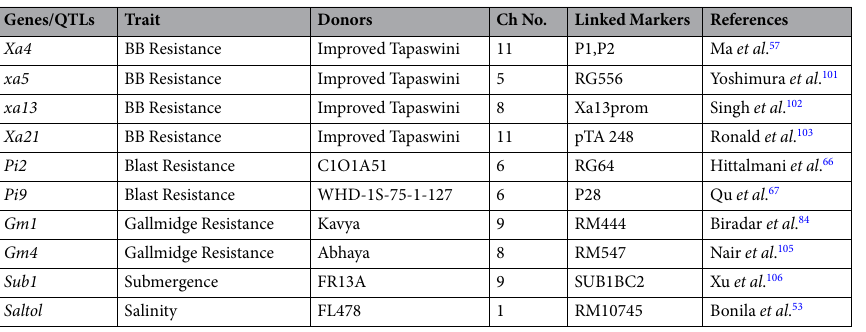
Table 1. List of resistance/tolerance genes/QTLs, donors and markers employed in the